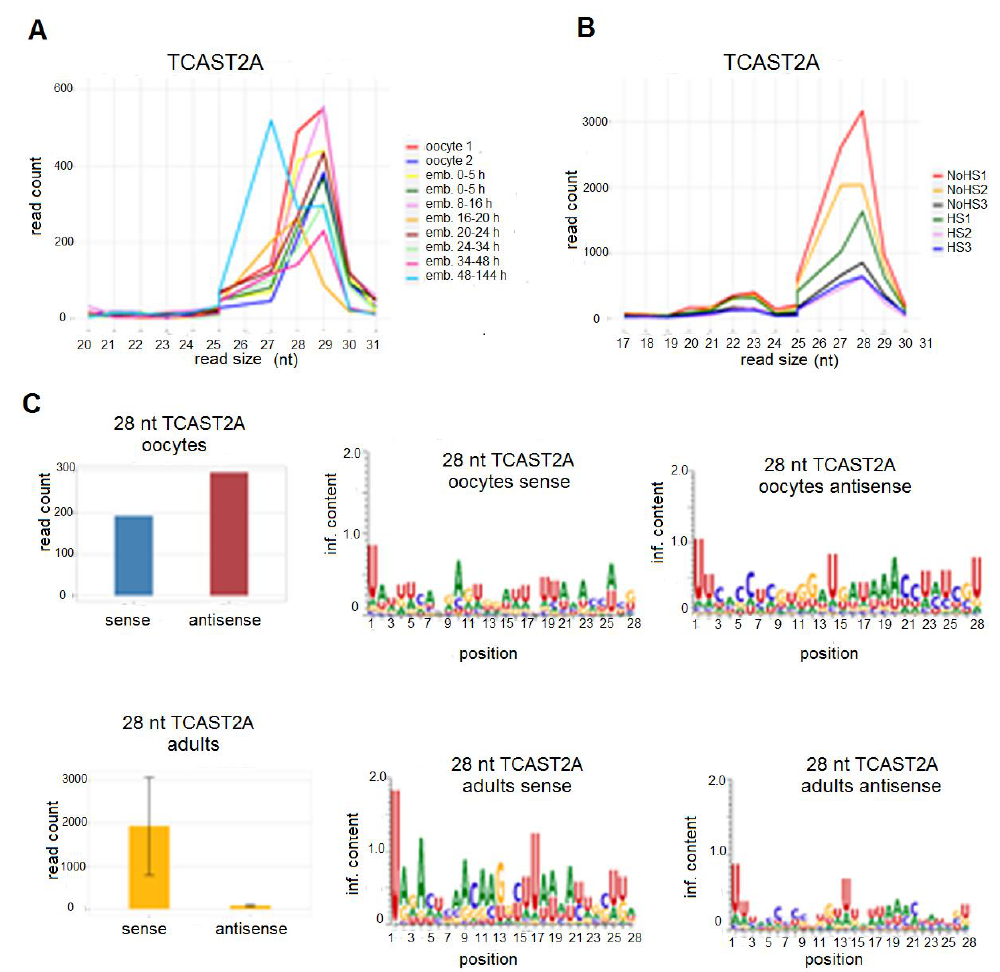
Figure 5. Size and count distribution of reads mapped to the TCAST2A satellite in T. castaneum oocyte and embryonic small RNA libraries ( A ) and in small RNA libraries of adults kept at normal temperature (NHS), as well as adults subjected to heat stress (HS) ( B ). 28 nt reads were mapped on the sense and antisense strand of TCAST2A in oocytes and adults, as well as the sequence logos for sense and antisense 28 nt reads ( C ). Int. J. Mol. Sci. 2021 , 22 , x FOR PEER REVIEW